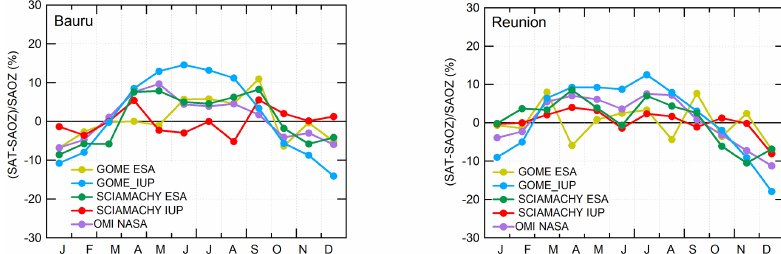
Figure 15. Relative difference of the NO 2 seasonal cycle between satellites and ground based observations at Bauru (left) and Reunion (right). GOME GDP5 (green), GOME IUP V1 (blue), SCIAMACHY IUP V2 (red), SCIAMACHY SGP5 (dark green), OMI DOAS V3 (purple).